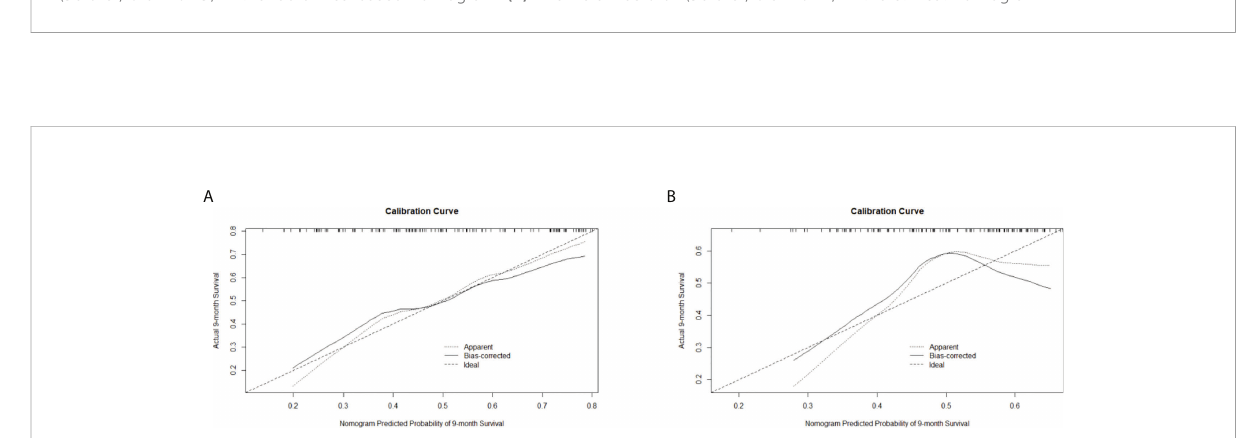
FIGURE 6 Receiver operating characteristic curves of different predictive nomograms for 9-month survival. (A) The area under the curve (AUC) was 0.71 (95% CI, 0.62 – 0.79) in the radiomics-based nomogram. (B) The AUC was 0.61 (95% CI, 0.51 – 0.71) in the clinical nomogram.